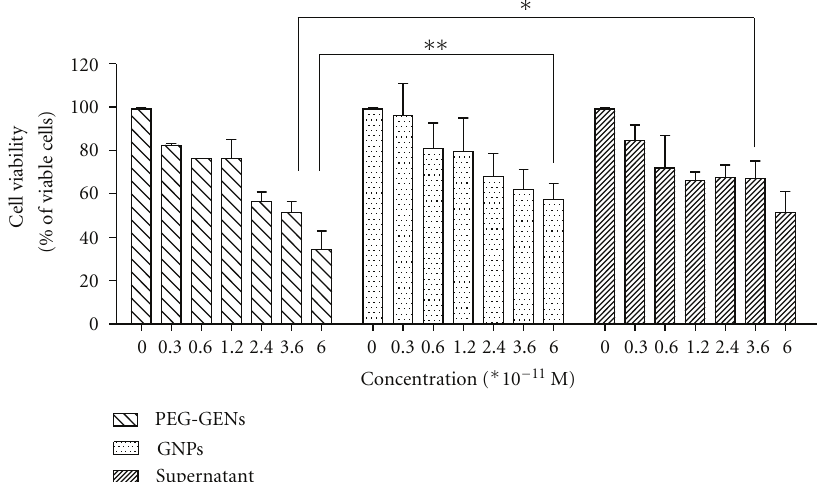
Figure 6: MTT test of epithelial cells from human retina (D407 cells viability (%)) treated with various concentrations of PEG-GENs and GNPs. The e ff ect of supernatant onto cell viability is also presented. Data are presented as means and standard errors of the mean (SEM): ∗ significant P < 0 . 05, ∗∗ very significant P < 0 . 01.